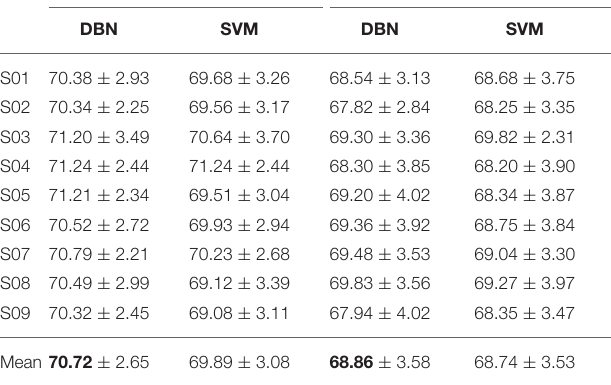
TABLE 5 | Statistical classification performance of the DBN and SVM for the incomplete EEG with point and chunk removal. Incomplete EEG (point form) (%) Incomplete EEG (chunk form)